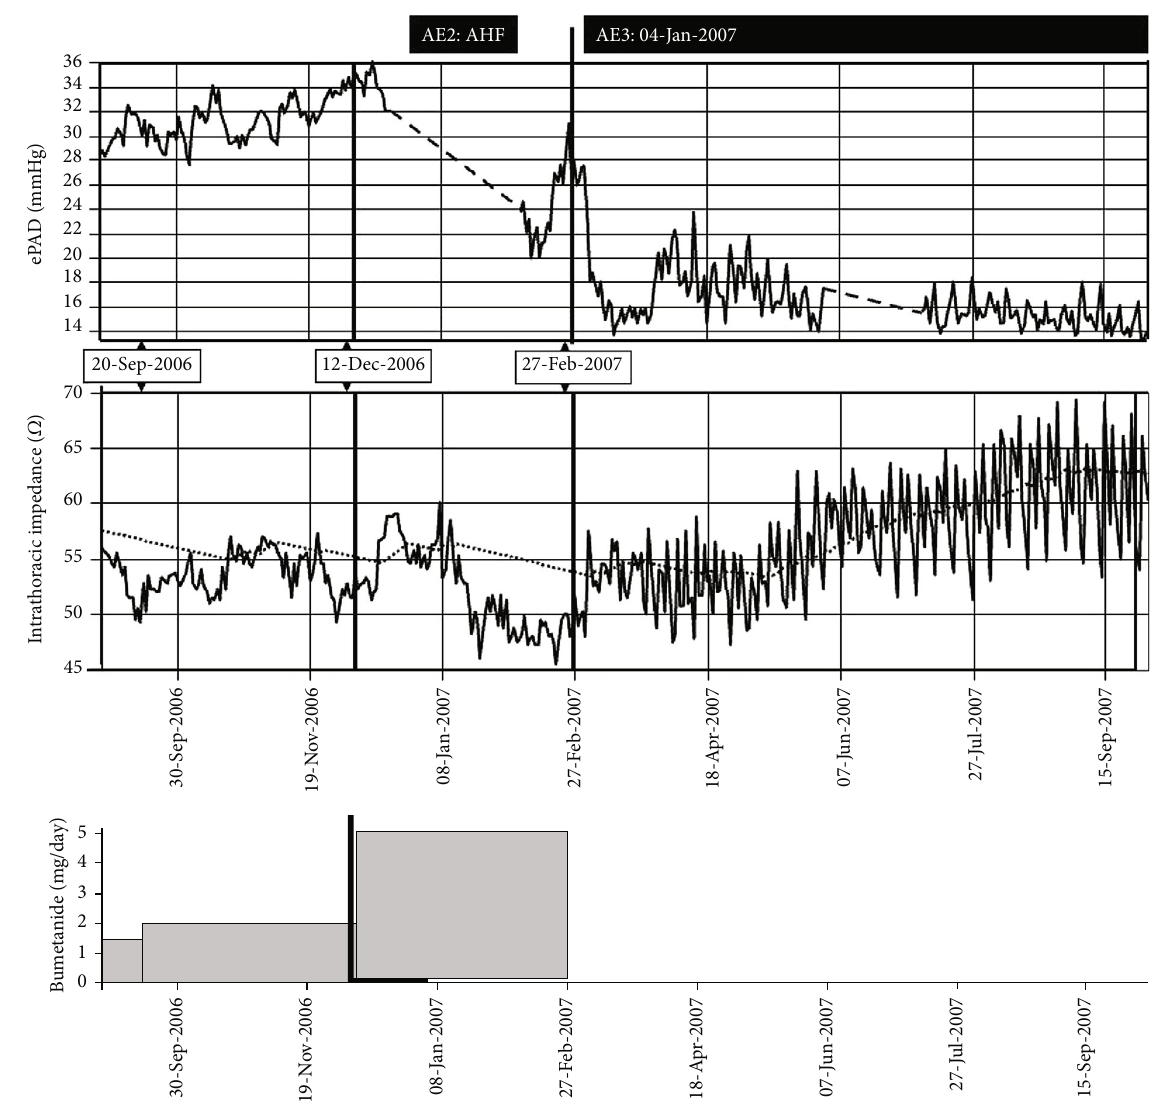
Figure 2: (a) ePAD (mmHg). (b) Intrathoracic impedance ( Ω ) with reference line (dotted). (c) Diuretic dose (bumetanide, mg/day). AE: adverse event. Dashed line indicates loss of ePAD